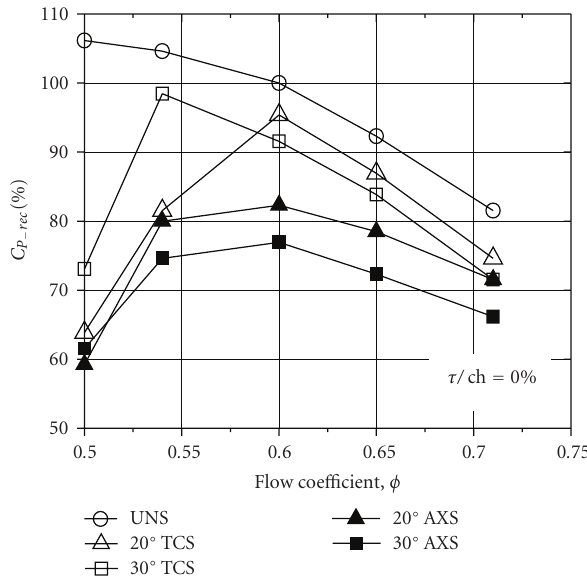
Figure 12: Static pressure recovery coe ffi cient in the